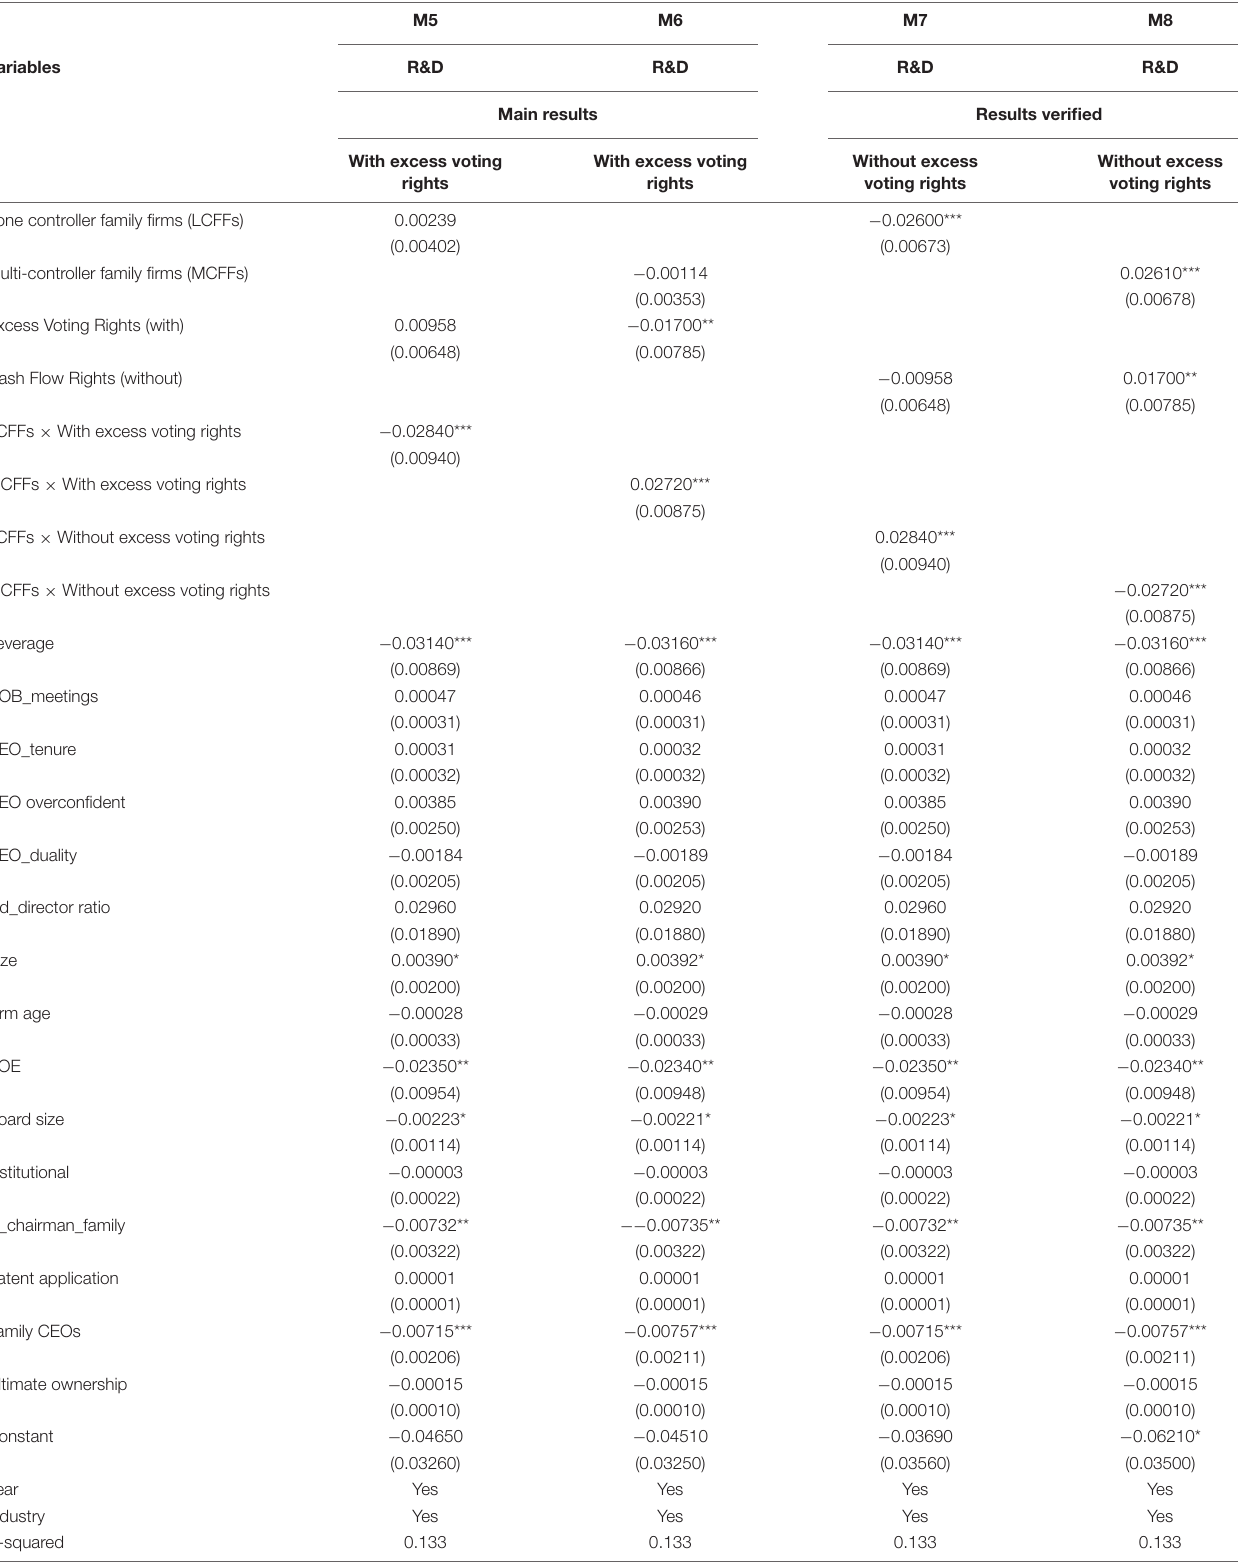
TABLE 6 | Regression results with continuous moderating